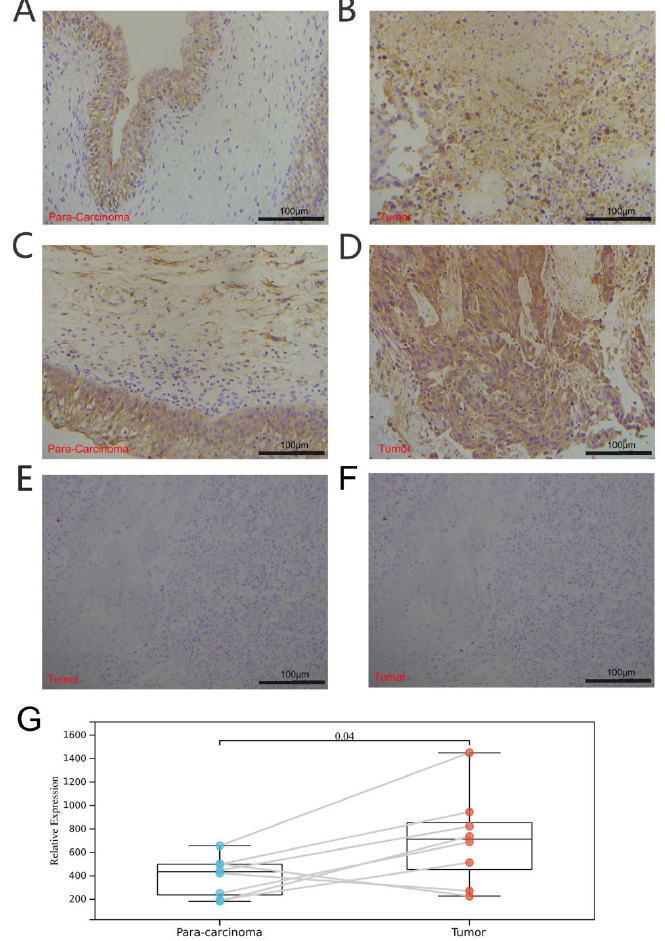
Figure 10. Correlation of immunotherapy outcome, TMB, MSI, and immune-activation-related genes with the expressions of TRPC4. * p < 0.05; ** p < 0.01; *** p < 0.001.